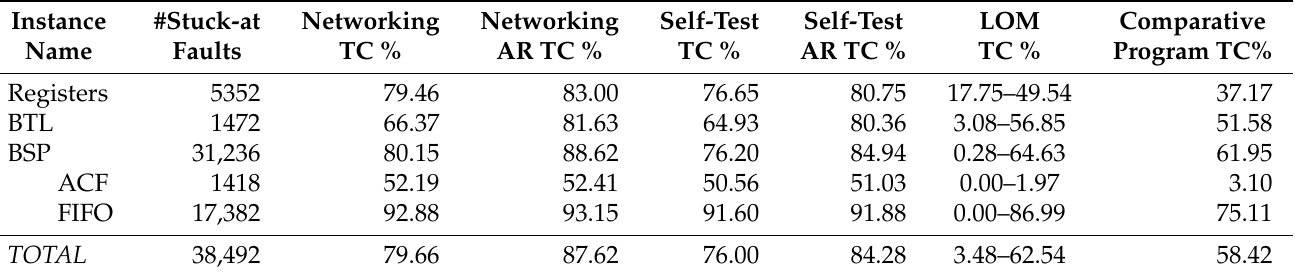
Table 2. Achieved stuck-at faults